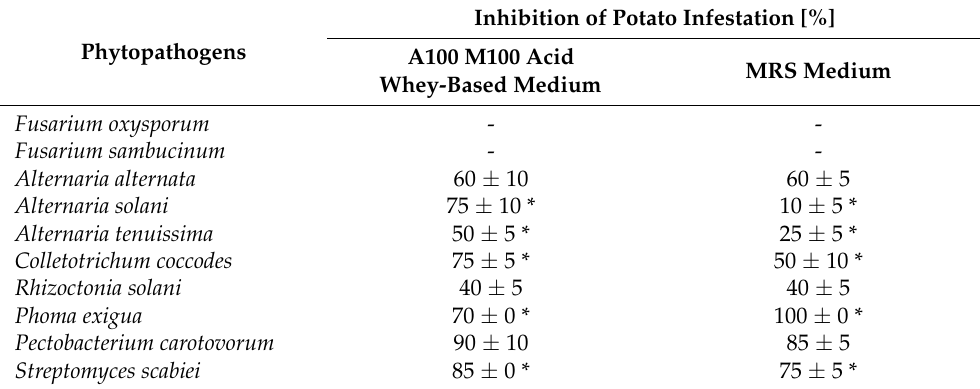
Table 4. Inhibition of potato seed cv. Impresja infestation treated with L. plantarum KB2 LAB 03 cultured on A100 M100 acid whey ‐ based medium against potato phytopathogens.